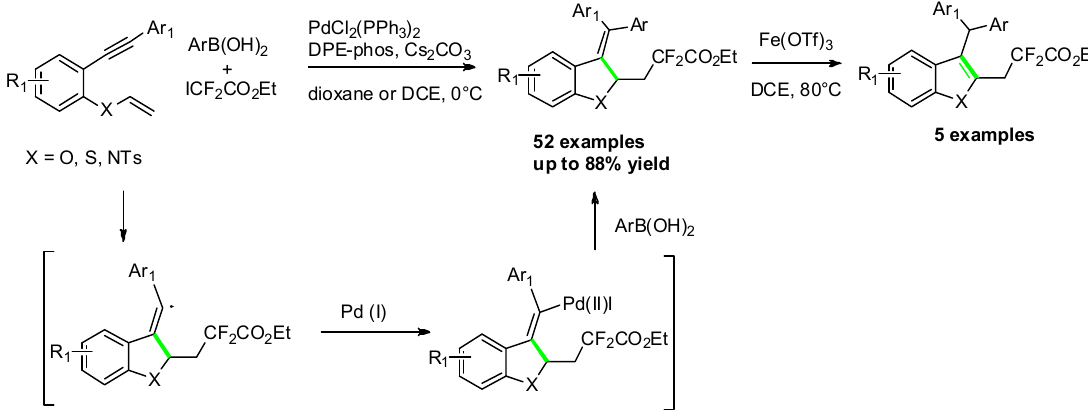
Scheme 21. Synthesis of benzofurans via o -alkynylphenyl vinylethers.